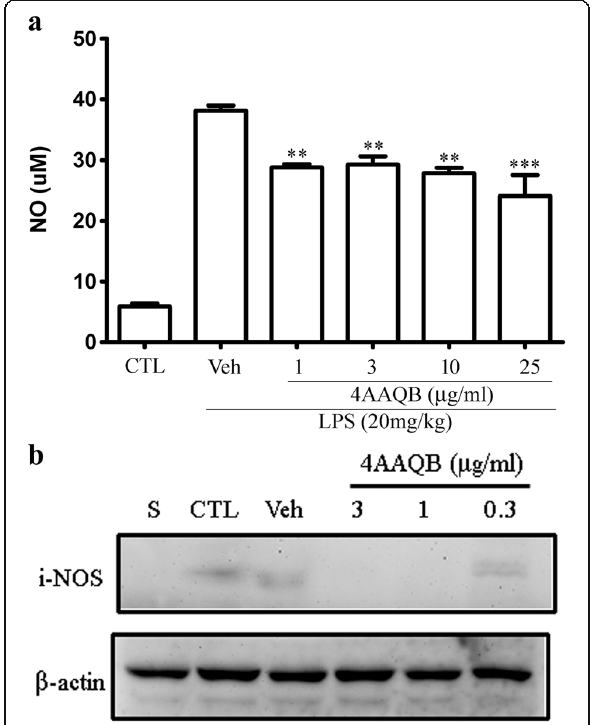
Fig. 4 The effects of 4AAQB on LPS-induced nitric oxide production and iNOS expression in RAW264.7 macrophages. a The cells were treated with LPS (100 ng/ml) only or with various concentrations of 4AAQB and the nitric oxide production was measured after 24 h. Control (CTL) values were obtained in the absence of LPS. Data were obtained from three independent experiments and expressed as means ± S.E.M. * p <0.05 compared with the LPS-activated only group. b RAW264.7 cells were treated with various concentration of 4AAQB and stimulated with LPS (100 ng/ml). Cells were harvested and iNOS was detected. Each experiment has been performed three